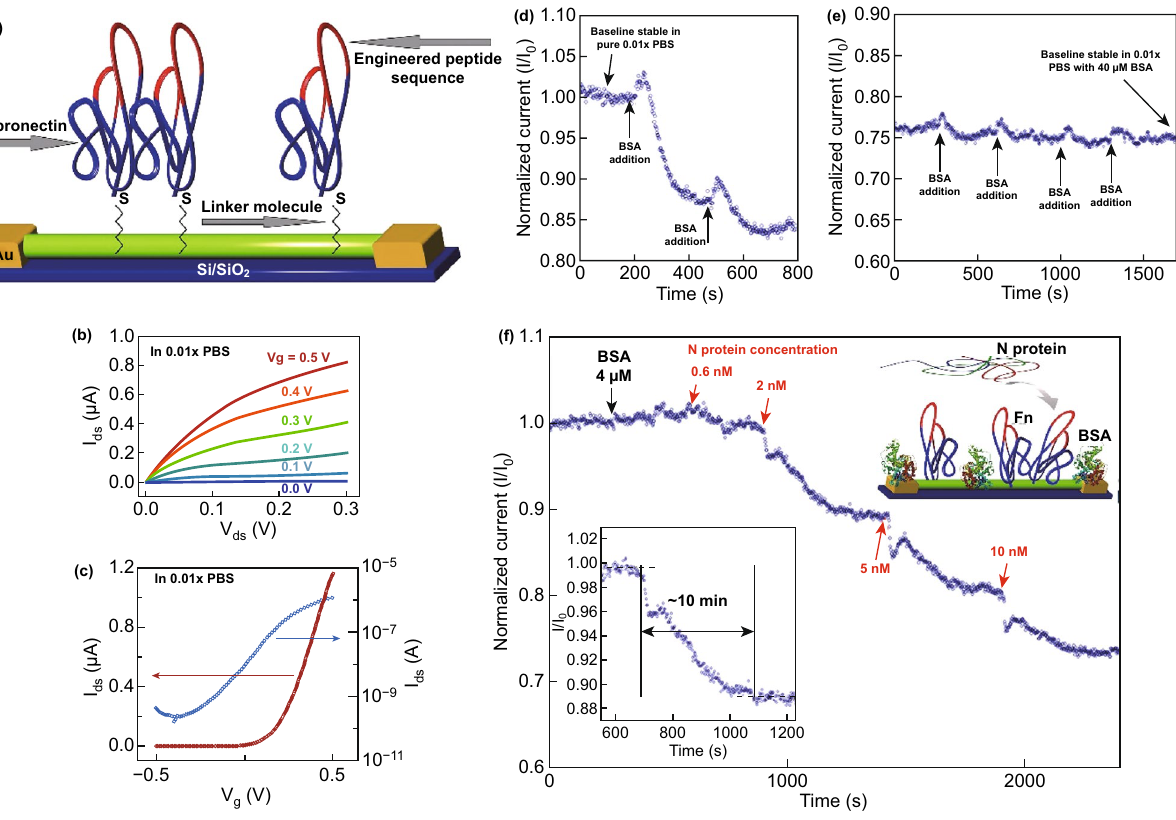
Fig. 10 a Schematic presentation of immobilized Fn on the exterior part of an In 2 O 3 nanowire FET apparatus device. The areas of Fn are highlighted in red with the plotted peptide sequence. Fn was connected to the related nanowires through the cysteine sulfhydryl group near the C‑terminus, distant from the binding location. b Curves pertinent to a family of I ds – V ds and c a typical I ds – V g curve (plotted both in logarithmic (blue)) and linear (red) achieved from one of our instruments functioning with the aqueous gate arrangement. Normalized electrical output ( I / I 0 ) versus time of a single functioning instrument. d – e Demonstrating the response curves to passivation upon the addition of consecutive aliquots of BSA. Upon increasing the BSA concentration (from pure 0.01* PBS), the baseline re‑equilibrates at lower values of S‑D current until stability is finally reached at 40 µM BSA, in 0.01* PBS. f Showing response for a nanowire device utilized with Fn. The red arrows show the times when the solution was increased to a specified concentration of N protein. The inset on the right side is the arrangement of our device through active sensing measurements. BSA protein was used to block sites for nonspecific binding. The Fn probe molecule was then used to specifically capture the target N protein. The inset on the left side is to show the plateau and the definition of response time. Adapted from Ref. [122]. (Color